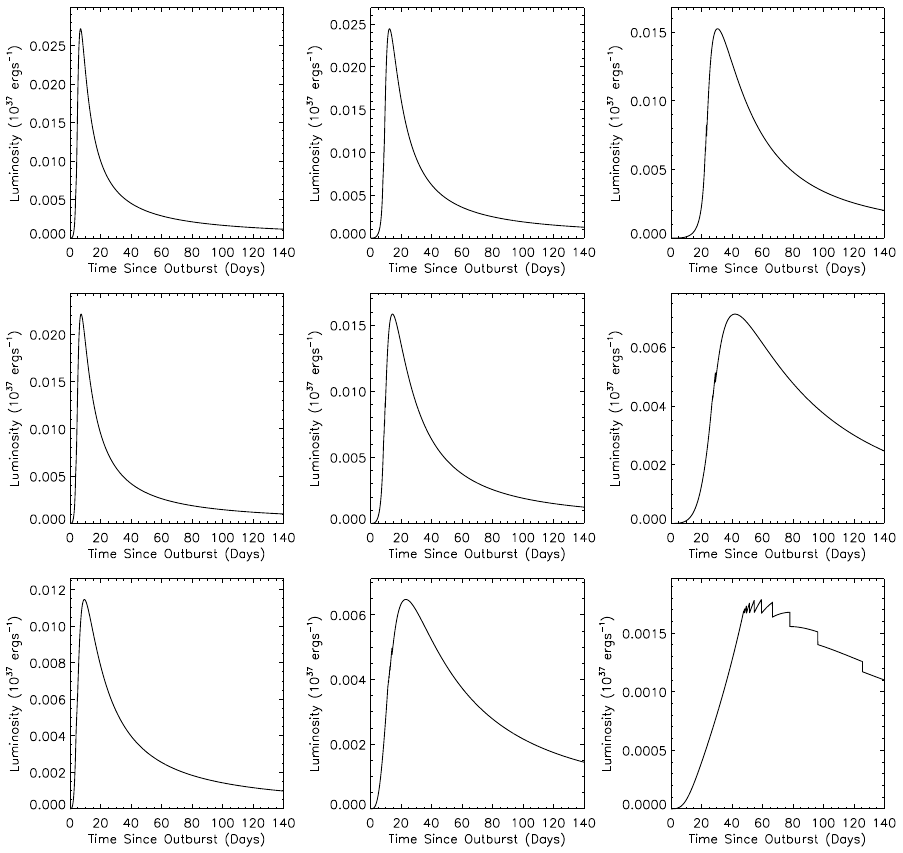
Fig. 5. Same as Figure 3, but with a Mira mass-loss rate of 10 − 7 M ⊙ yr − 1